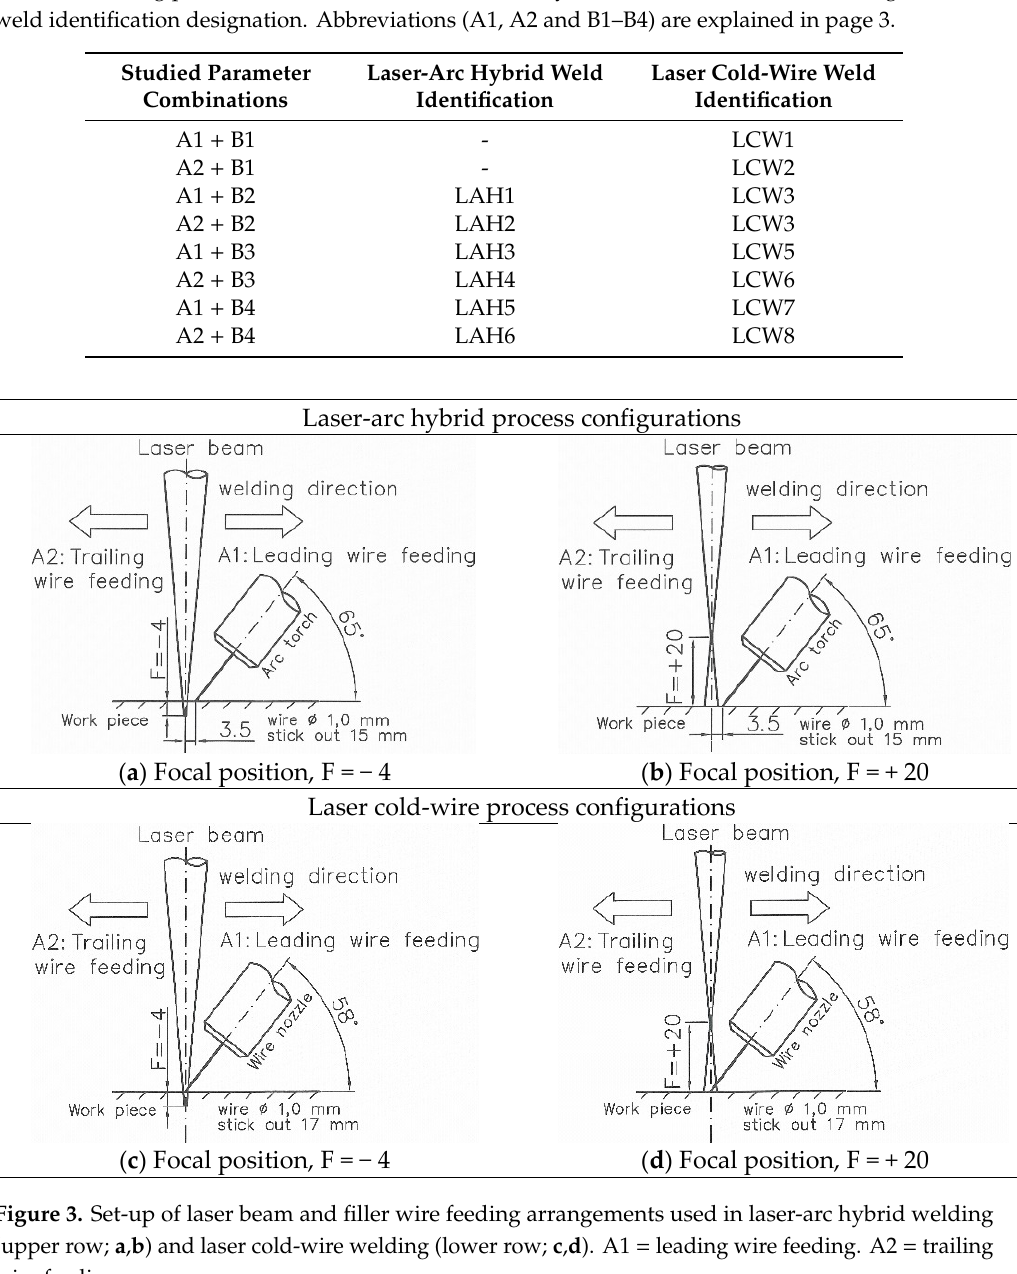
Table 3. Welding parameter combinations in laser-arc hybrid and laser cold wire welding tests and weld identification designation. Abbreviations (A1, A2 and B1–B4) are explained in page 3.